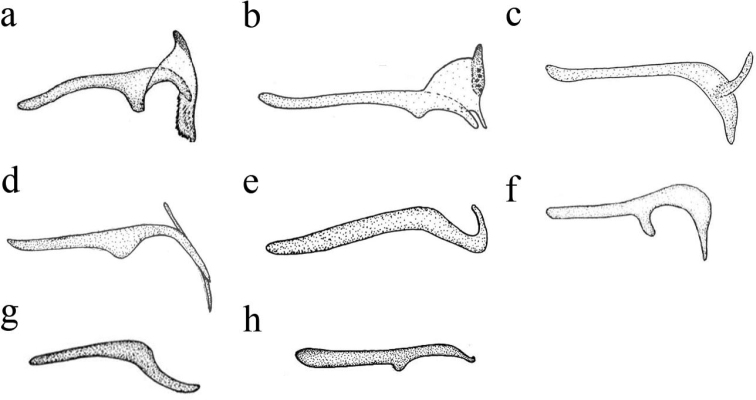
Gonocoxites 10 of Coniopteryx species, lateral view aC.
dactylironsbC.
protrufronscC.
aliferadC.
pygmaeaeC.
crispicornisfC.
aspoeckigC.
chouihC.
plagiotropa.